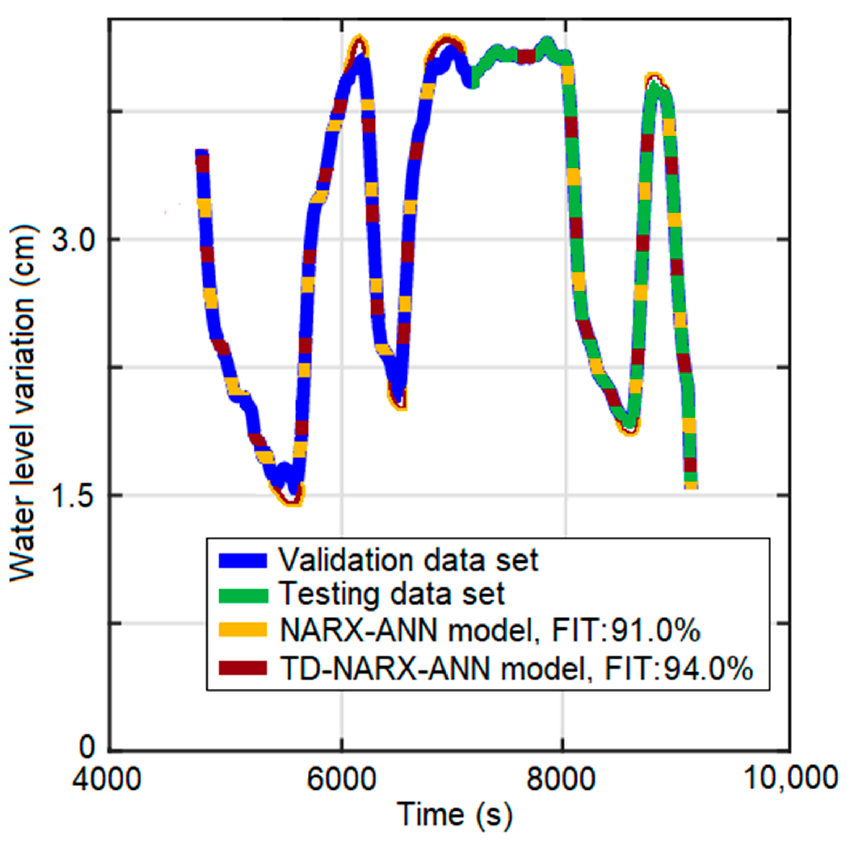
Figure 6. Validation results of the NARX-ANN and TD-NARX-ANN-based models with the validation and testing data sets.